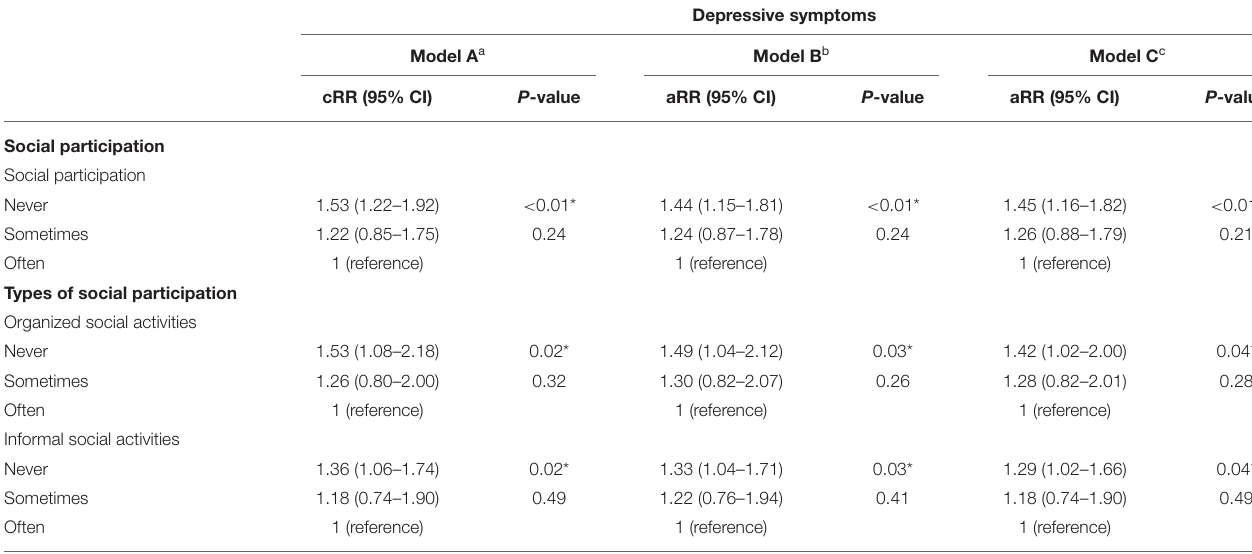
TABLE 3 | Association between social participation and the risk of depressive symptoms in univariate and multivariate models.